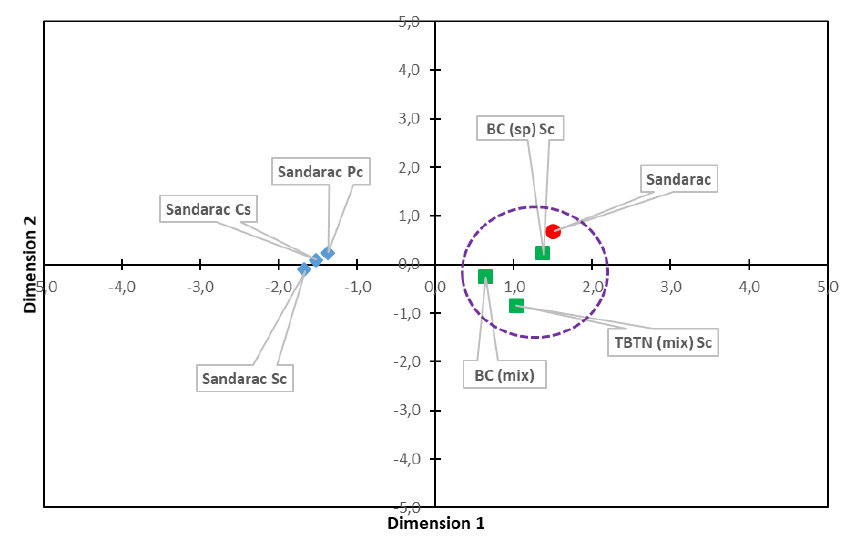
Figure 5. MDS analysis of the sandarac samples: blank sample (type 1, red circle); samples inoculated with microorganisms without biocide (type 3, blue diamonds); and samples inoculated with Pc, Cs and Sc, and treated with the studied biocides (type 4 (mix), and 5 (sp), green squares). BC = benzalkonium chloride, TBTN = tributyltin naphtenate, and OPP = ortophenyl phenol. Cs = C. sitophila ; Pc = P. chrysogenum ; Sc = S. celluloflavus .